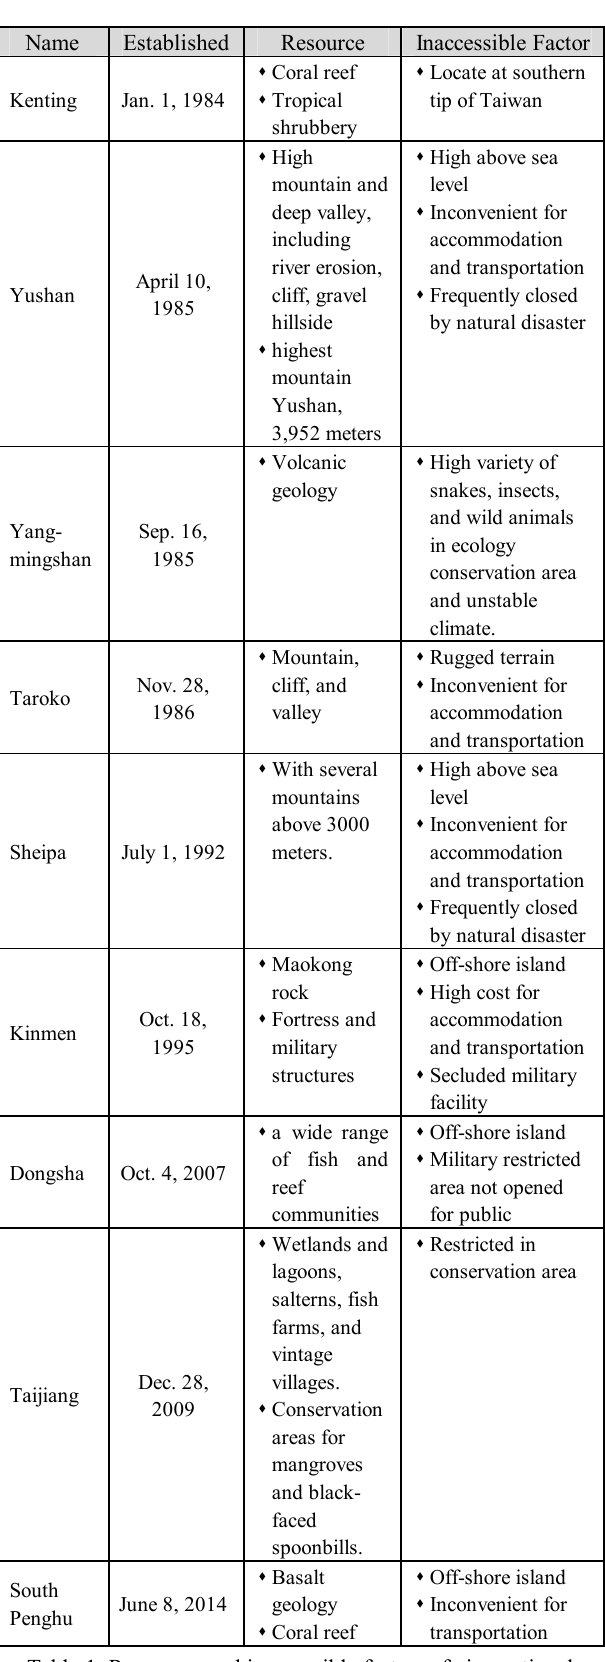
Table 1. Resources and inaccessible factors of nine national parks in